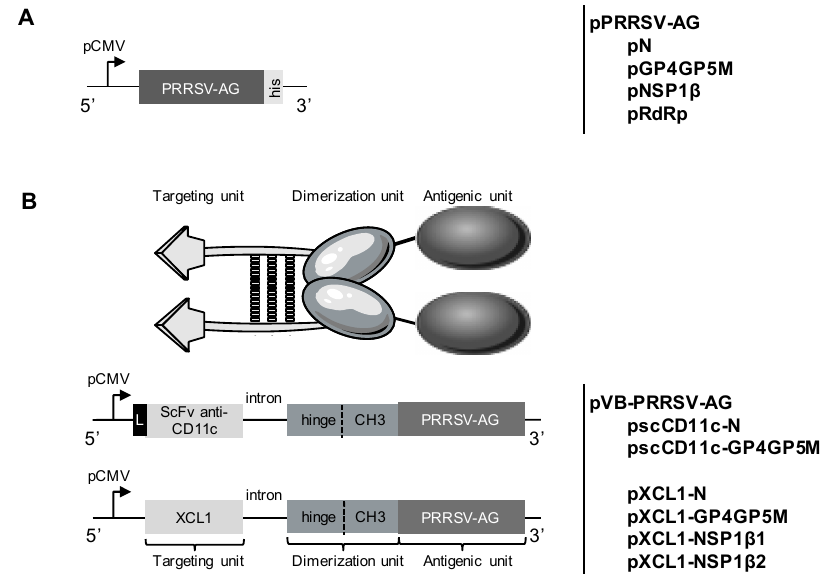
Figure 1. DNA constructs for expression of PRRSV-AGs in native forms or in VBs targeting XCR1 and CD11c. ( A ) Four PRRSV AG constructs encompassing six PRRSV AG (FL13 isolate) were codon-optimized, terminated by a 6 × His tag and cloned under the CMV promoter. The four constructs are pN, pGP4GP5M chimera, pNSP1 β and pRdRp. ( B ) The VB-PRRSV-AGs include a targeting unit, a dimerization domain derived from the hinge and CH3 domains of human IgG3, and the four PRRSV-AGs described in ( A ). The VB sequences were also cloned under the CMV promoter. Two constructs, pscCD11c-N and pscCD11c-GP4GP5M, include an anti-pig CD11c scFv sequence for targeting the N and GP4GP5M chimera, respectively; the added exogenous murine Ig leader sequence is represented at the 5’ end by a black box. Four constructs, pXCL1-N, pXCL1-GP4GP5M, pXCL1-NSP1 β 1 and pXCL1-NSP1 β 2 target the N antigen, the GP4GP5M chimera, the AA1-202 NSP1 β 1 fragment and the AA182-383 NSP1 β 2 fragment, respectively.